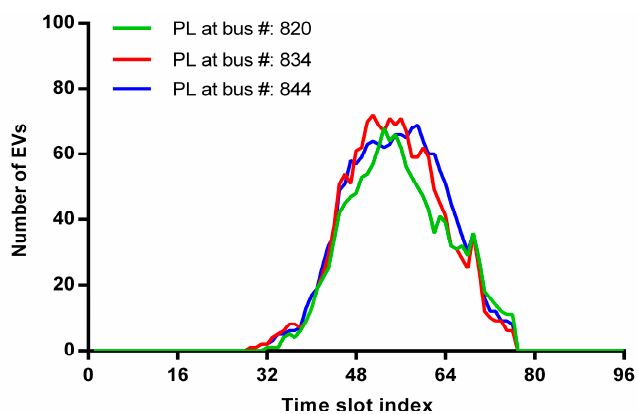
Figure 9. Random distribution of arrival and departure times of EVs for the PLs connected to the three buses: ( a ) Represent the PL at bus #820; ( b ) Represent the PL at bus #834; ( c ) Represent the PL at bus #844.